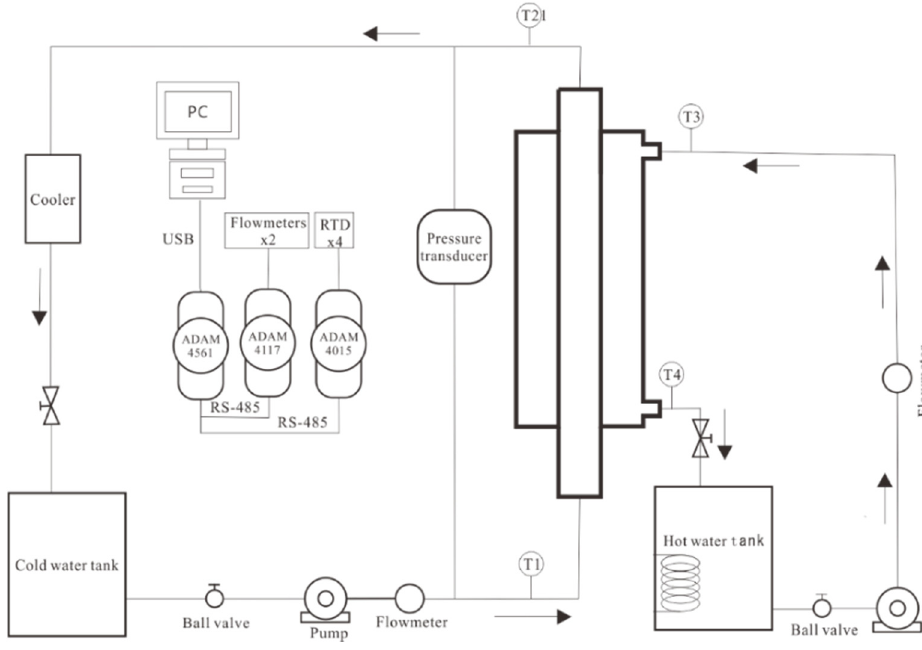
Figure 1. Experimental process.